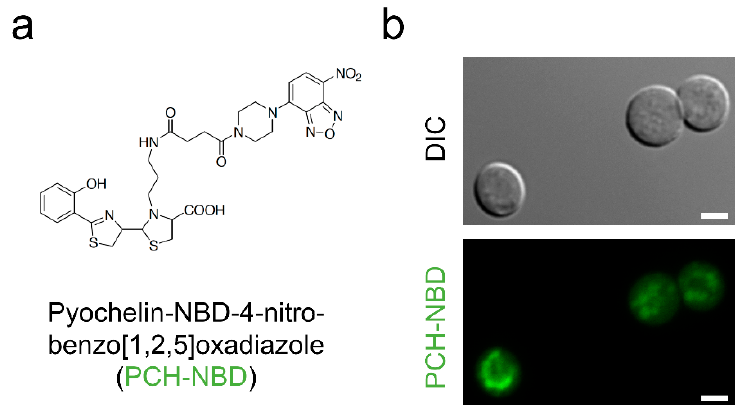
Figure 5. Structure ( a ) and penetration ( b ) of pyochelin-4-nitrobenzo[1,2,5]oxadiazole (PCH-NBD) in A. fumigatus swollen conidia. Scale bar represents 5 mm. Methodology is described in Supplementary Materials.